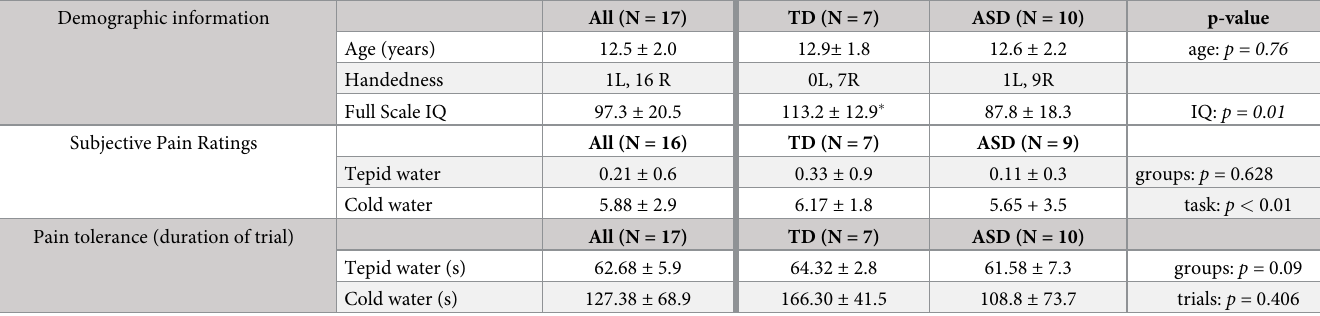
Table 2. Participant characteristics, average self-assessment of pain ratings and pain tolerance. Demographic information All (N = 17)